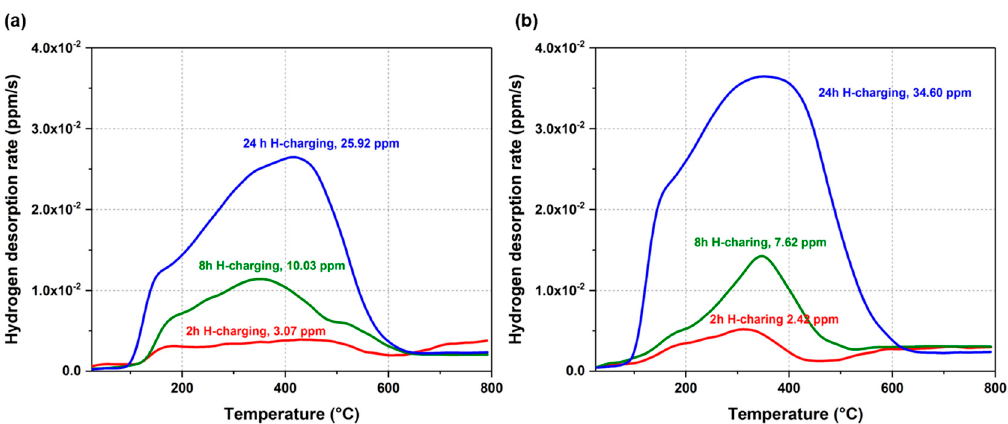
Figure 7. Hydrogen desorption rate as a function of temperature in ( a ) austenite-reverted- transformation (ART) specimen; and ( b ) AUS + ART specimen. (ART) specimen; and ( b ) AUS + ART